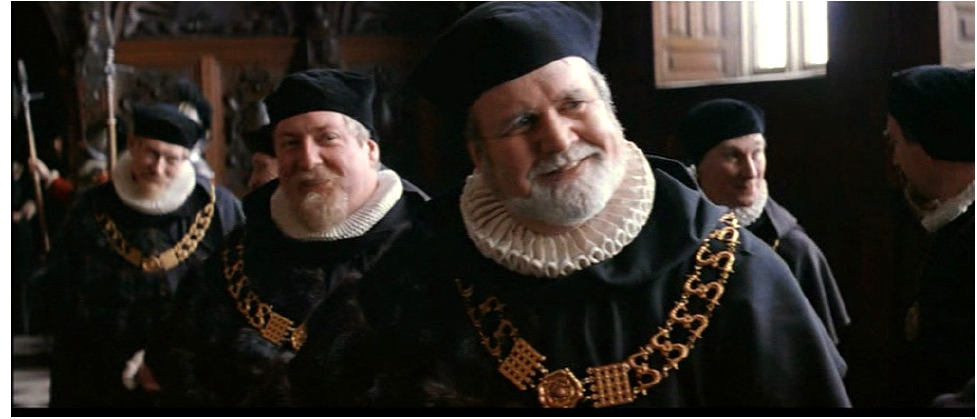
Figure 18: The English court officials scrutinise their unprecedented visitor Poca- hontas.